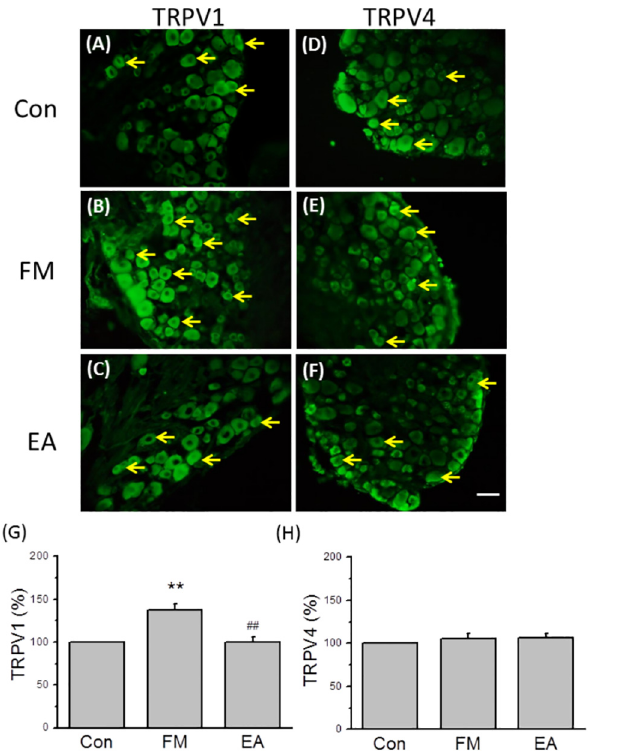
Fig 3. Upregulation of TRPV1 immunohistochemical expression in L3-5 DRG neurons from FM model mice and reversal by EA. (A-C) Immunohistochemical staining showing TRPV1-positive cells (green) in control (A), FM (B), and EA groups (C). (D-F) Immunohistochemical staining showing TRPV4-positive neurons (green) in control (D), FM (E), and EA groups (F). (G, H) Proportions of immunopositive neurons. Con = Control; FM = acid induced fibromyalgia pain; EA = FM pain with electroacupuncture. DRG = dorsal root ganglion. Arrows identify immunopositive neurons. Scale bar = 50 μ m.